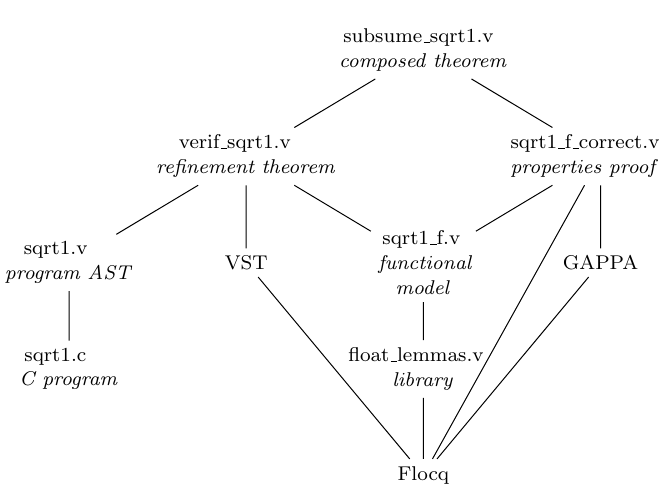
Fig. 1. Module and tool dependency. The .c file is a C program; the .v files are Coq files (definitions and proofs); and the tools and libraries VST, Flocq, and GAPPA are implemented mostly in